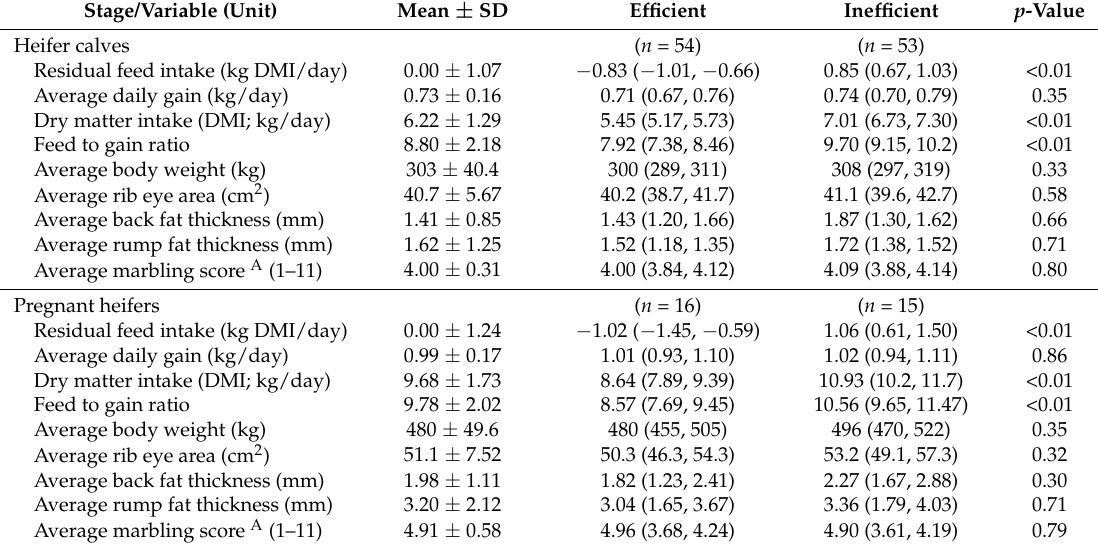
Table 1. Descriptive statistics (mean and standard deviation, SD) and least square means (confidence interval) of productivity traits by developmental stage of the heifers and feed efficiency